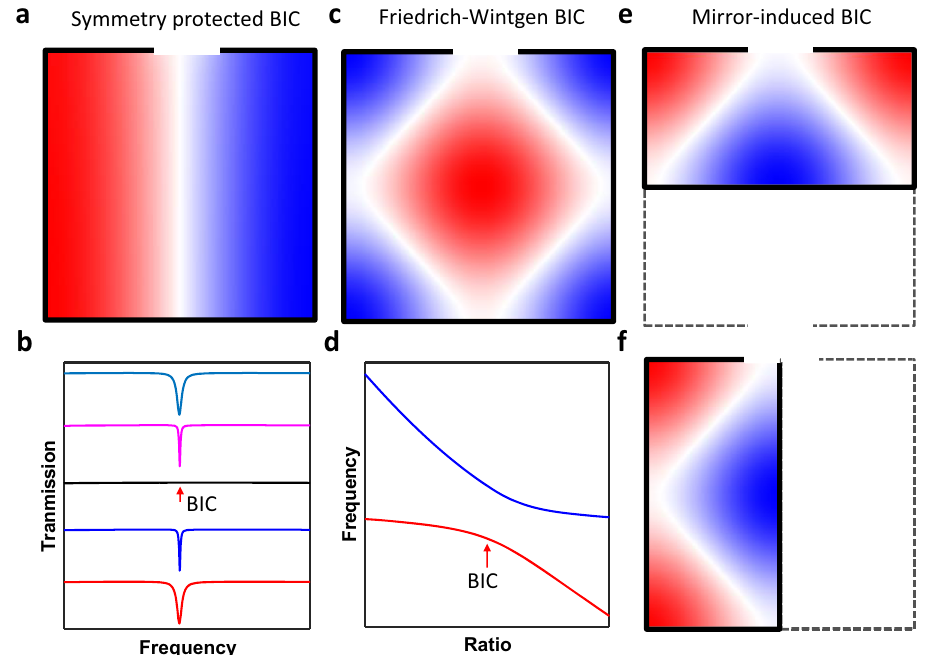
Fig. 1 BIC in an open acoustic resonator. a Symmetry-protected BIC. b Transmission spectra evolution as structure asymmetry is introduced. When the asymmetry ratio decreases to 0 (black curve), ideal BIC occurs. c Friedrich – Wintgen BIC induced by mode interferences. d Resonant frequency of high- Q and low- Q modes as a function of size ratio of the open resonator. e Mirror-induced BIC for mirror along the x -axis. f Mirror-induced BIC for mirror along the y